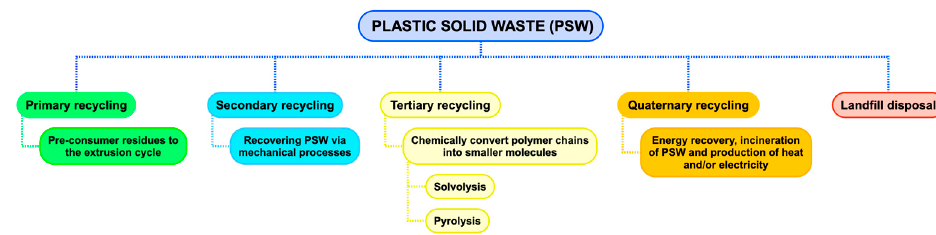
Figure 1. Plastic Solid Waste (PSW) management.